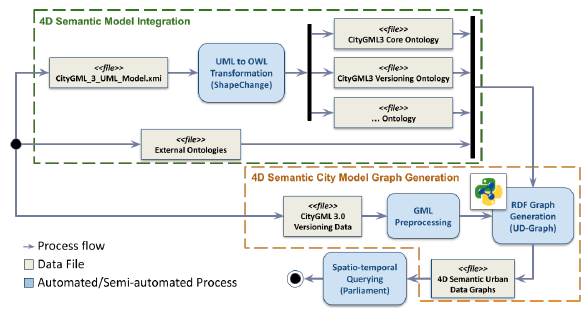
Figure 4. Proposed 4D Semantic Model Integration and Graph Generation